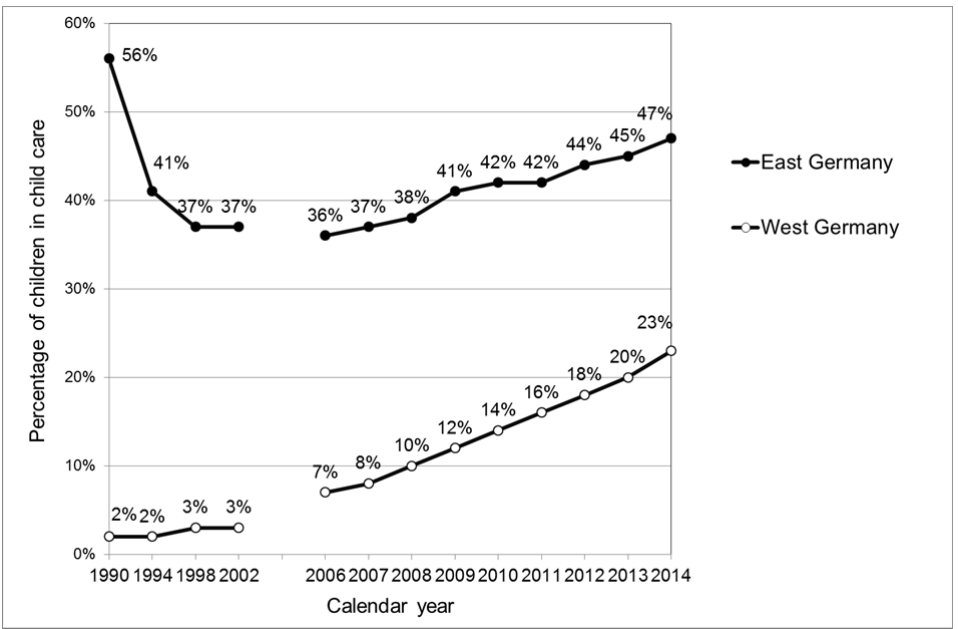
Figure 1 : Child care for children ages 0-2, East and West Germany 1990-2014